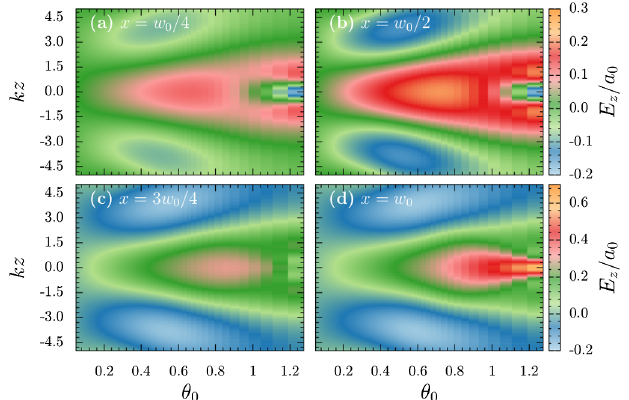
2. Plot showing the (normalized) amplitude of the longi- x; 0 ; z Þ =a 0 , as a function of the focusing tudinal electric field, E z ð parameter θ 0 and the longitudinal coordinate z for different values of x . The field component is calculated at x ¼ w 0 = 4 (a), x ¼ w 0 = 2 (b), x ¼ 3 w 0 = 4 (c) and x ¼ w 0 (d). (It should be noted that as we change the focusing parameter the value of w 0 also changes.) It can be seen that for weak focusing ( θ 0 → 0 ) the longitudinal field tends to zero. As we increase the focusing the amplitude rises, becoming a significant fraction of the transverse